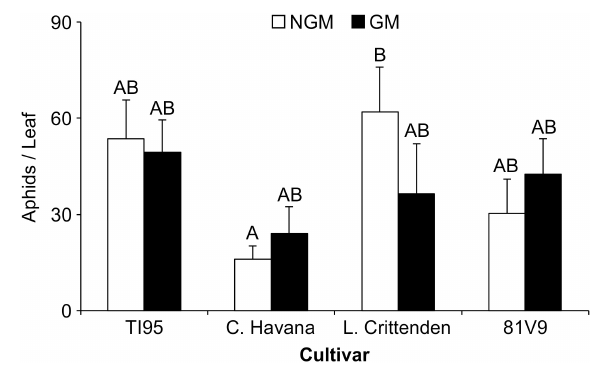
FIGURE 1 | PFA has no effect on short-term tobacco aphid survival and fecundity. Mean aphid numbers ± S.E. on GM and NGM tobacco cultivars. Aphid numbers were averaged between 3 leaves per plant for 3 separate trials under field conditions. Bars with the same letter are not statistically different (2-way ANOVA, Tukey’s pairwise comparison, P < 0.05). Error bars represent the standard error of the